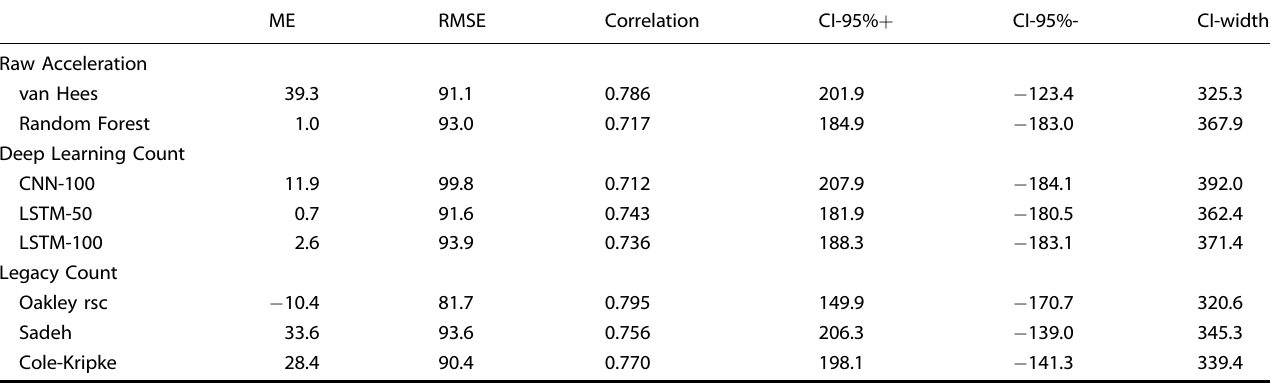
Table 2. Bland-Altman statistics for wake after sleep onset (WASO) comparison between PSG and the sleep algorithms applied to wrist-based